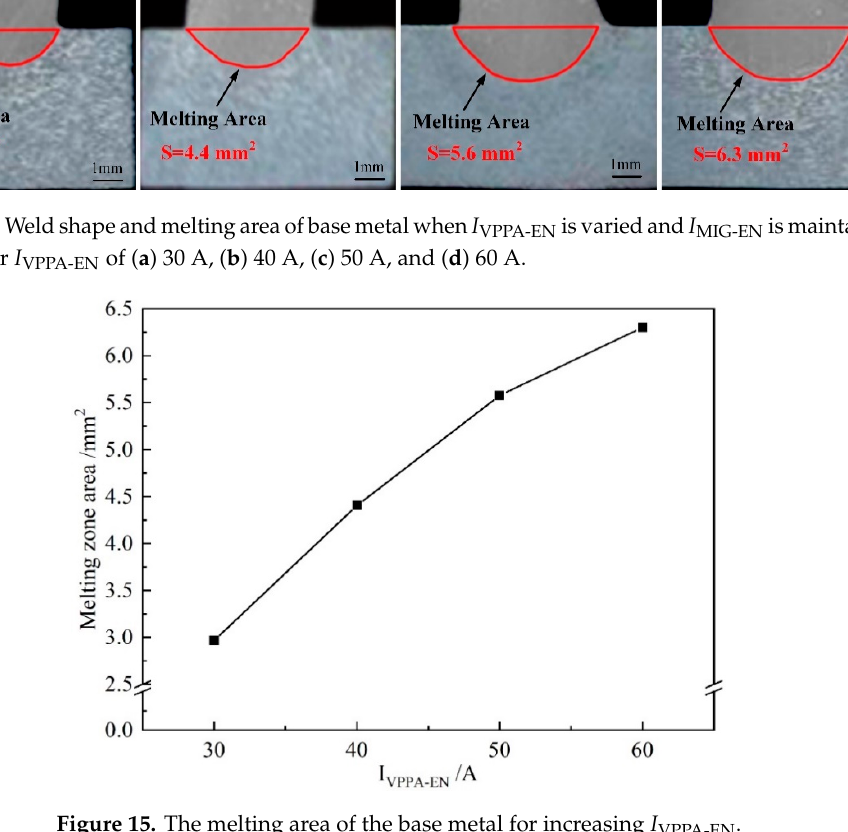
Figure 15. The melting area of the base metal for increasing I VPPA-EN .